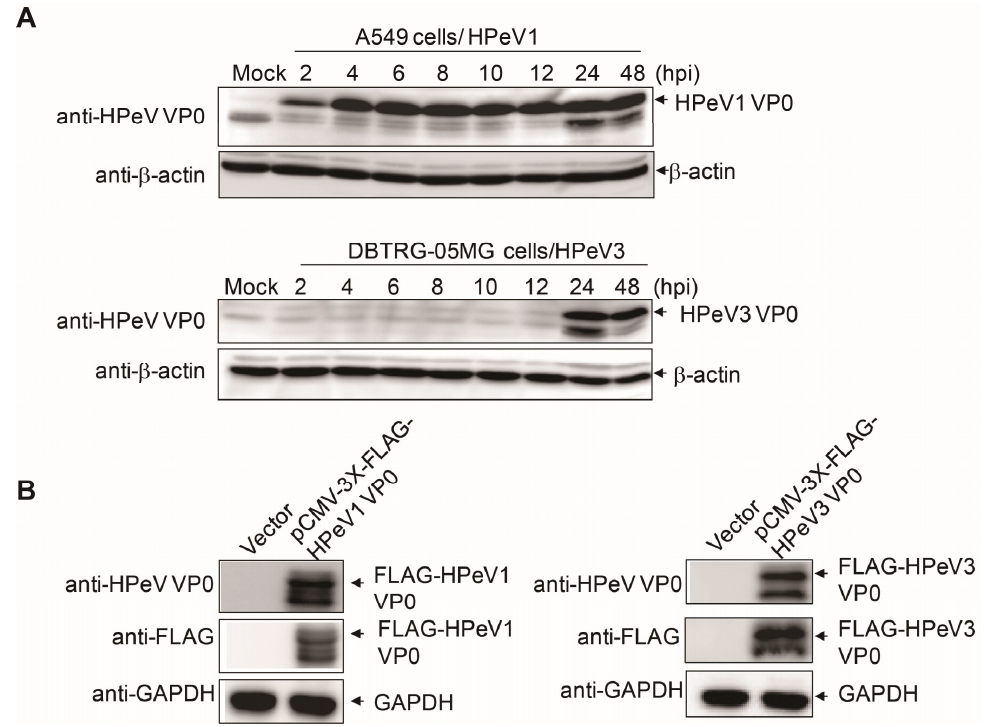
Figure 3. Immunoblotting assay with anti-HPeV VP0 antibody. ( A ) A549 cells (1 × 10 5 , upper panels) and DBTRG-05MG cells (1 × 10 5 , lower panels) were infected with HPeV1 and HPeV3 (MOI = 5), respectively. Cell lysates were harvested at various times post-infection (2 to 48 h) for VP0 detection by anti-HPeV VP0antibody. β -actin was a loading control. ( B ) pCMV-3X-FLAG-HPeV1 VP0 or -HPeV3 VP0plasmid (2 µ g) was transfected into Vero cells (3 × 10 5 ) for 30 h. The ectopic expression of FLAG-HPeV1 VP0 or -HPeV3 VP0 was detected by immunoblotting with anti-HPeV VP0 and anti-FLAG antibodies. GAPDH was a loading control.